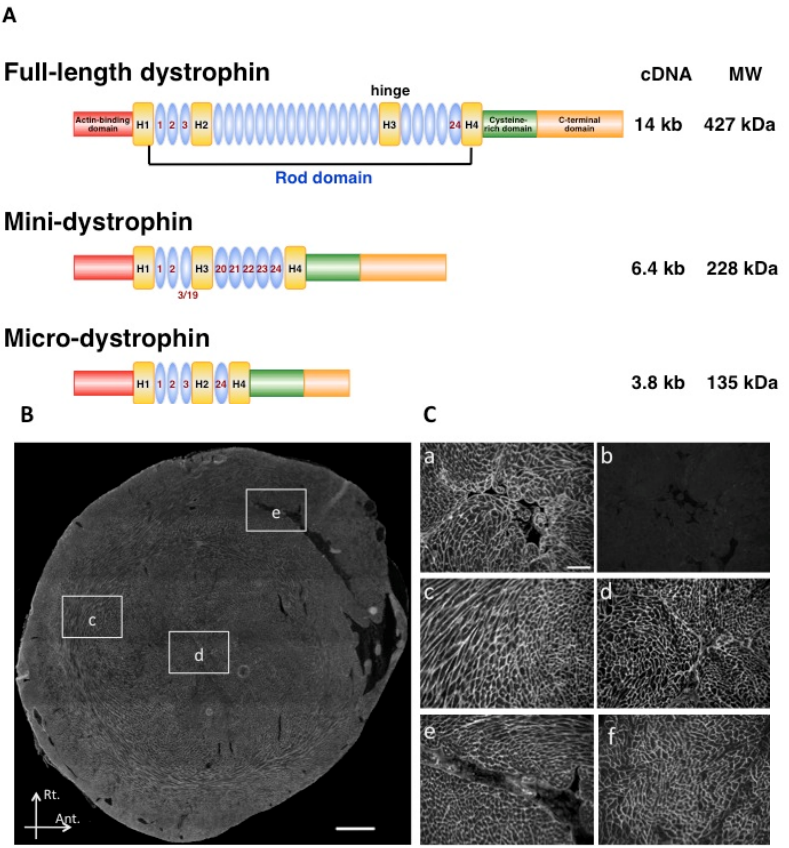
Figure 2. AAV9 vector-mediated cardiac transduction. ( A ) Structures of full-length and truncated dystrophin. Helper-dependent adenovirus vector can package 14-kb of full-length dystrophin cDNA because of the large-sized deletion in its genome. A mini-dystrophin is cloned from a patient with Becker muscular dystrophy, which is caused by in-frame deletions resulting in the synthesis of partially functional protein. A truncated micro-dystrophin cDNAs harboring only four rod repeats with hinge 1, 2, and 4 and a deleted C-terminal domain (delta CS1) is constructed to be packaged in the AAV vector. ( B ) Transverse section of mdx mouse heart at mid-ventricular level 24 weeks after rAAV9-mediated transduction of micro-dystrophin , stained with anti-dystrophin antibody NCL-DysB. Scale bar, 500 µm. ( C ) Expression of dystrophin in C57BL10 hearts at the sarcolemma (a), while it is absent in mdx hearts (b). Magnified views of sections from the center of the left ventricle at 28 weeks (c-e) show micro-dystrophin expression in the areas indicated in B (scale bar, 100 µm). At 74 weeks after transduction, mdx mice still retain extensive expression of micro-dystrophin